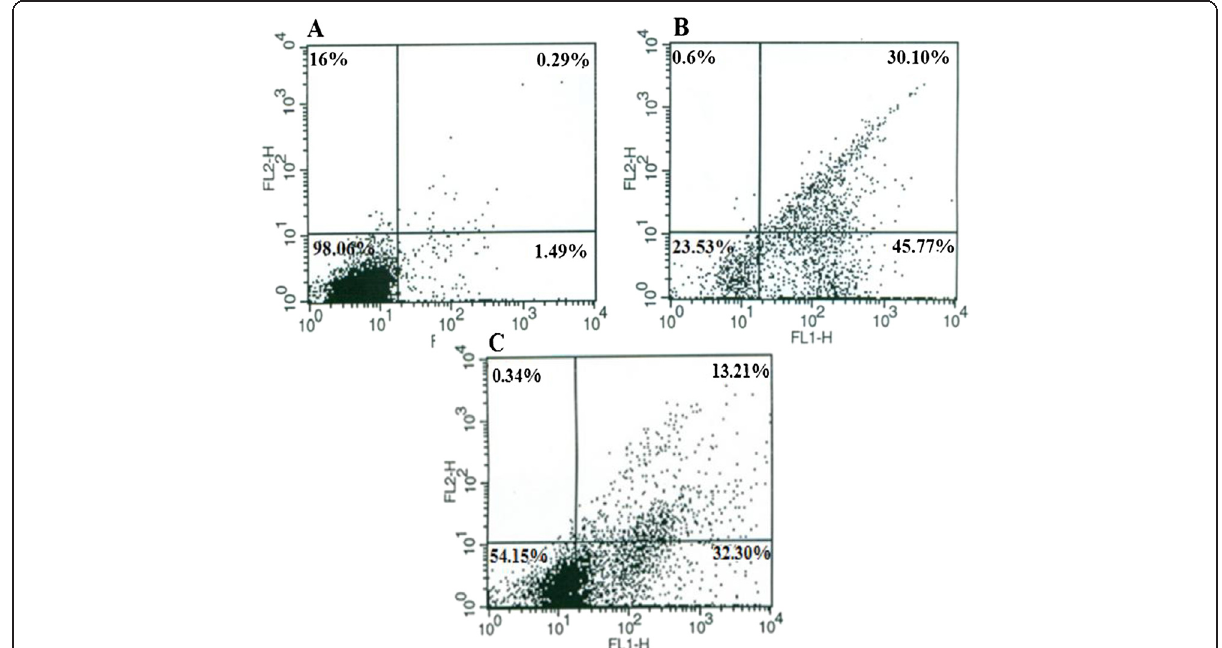
Figure 3 Characterization of BV and BV/Pd (II) complex-induced apoptosis in MOLT-4 cells by flow cytometry. Cells were cultured (A) without any component (control), (B) with BV and (C) with BV/Pd (II) complex for 24 hours. Note that 32.30% of the cells exposed to Cc 50 value of these two components simultaneously [1 μ g/mL BV/0.85 μ M Pd (II) complex] enter early apoptosis